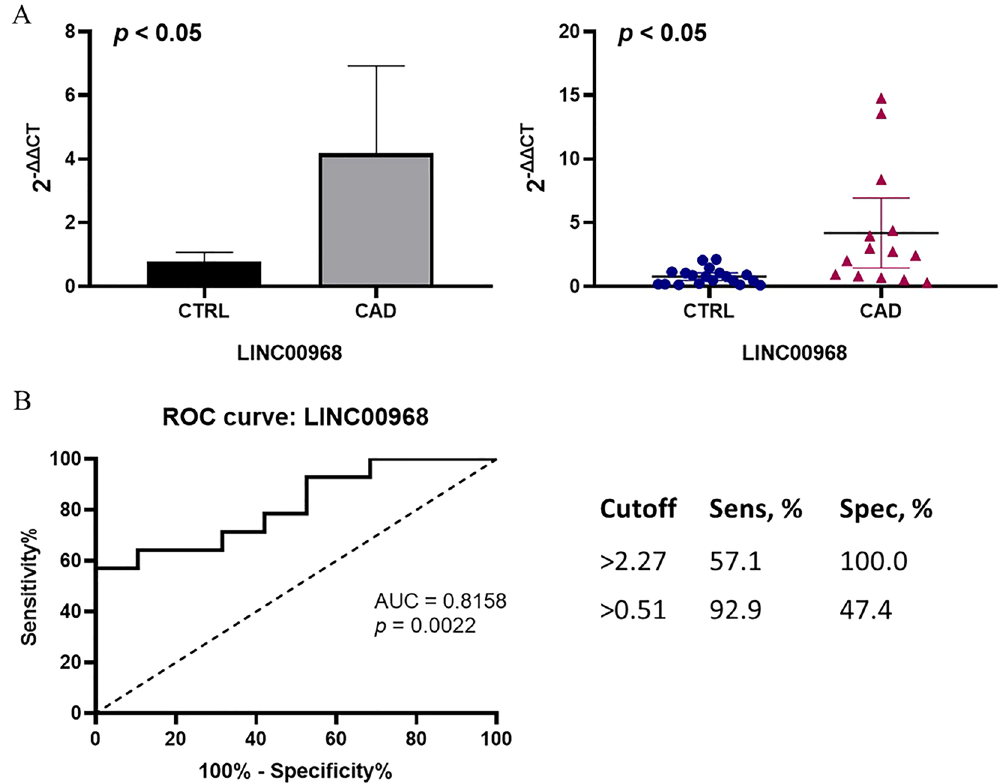
Figure 3. In CAD group, EAT overexpresses LINC00968; LINC00968 may act as a candidate biomarker of CAD. ( A ) Comparison of LINC00968 expression between CAD group and control group by verification via RT-qPCR. ( B ) ROC curve of LINC00968. The areas under the curve of LINC00968 was 0.8158 ( p = 0.0022, 95% confidence interval 0.6653 to 0.9663).